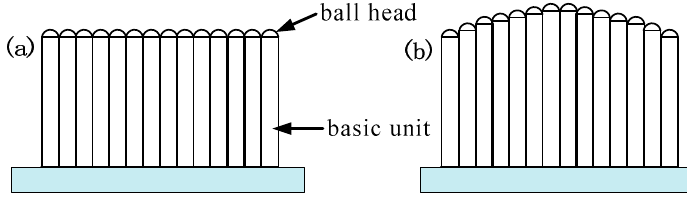
Figure 1. Schematic diagram of multi-point die: ( a ) before adjustment; ( b ) after adjustment.